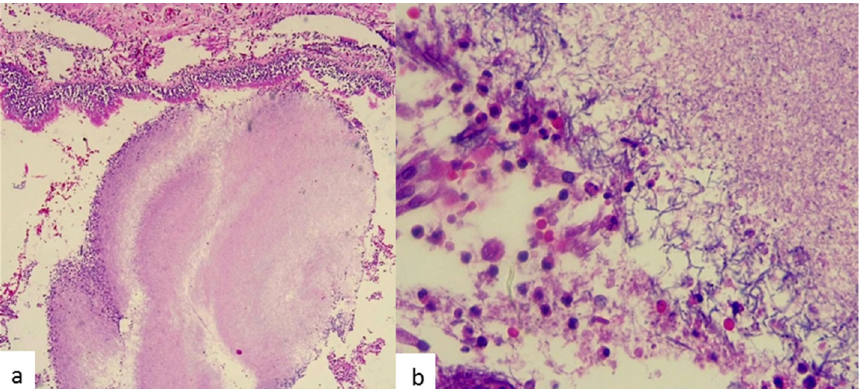
Figure 2. Histopathological examination of the lesion at low magnification (10 × ; H&E stain) shows Actinomyces colonies, with the characteristic “sulfur granules” ( a ), and at higher magnification (100 × ; H&E stain) demonstrates filamentous nonsporulating microorganisms ( b ).